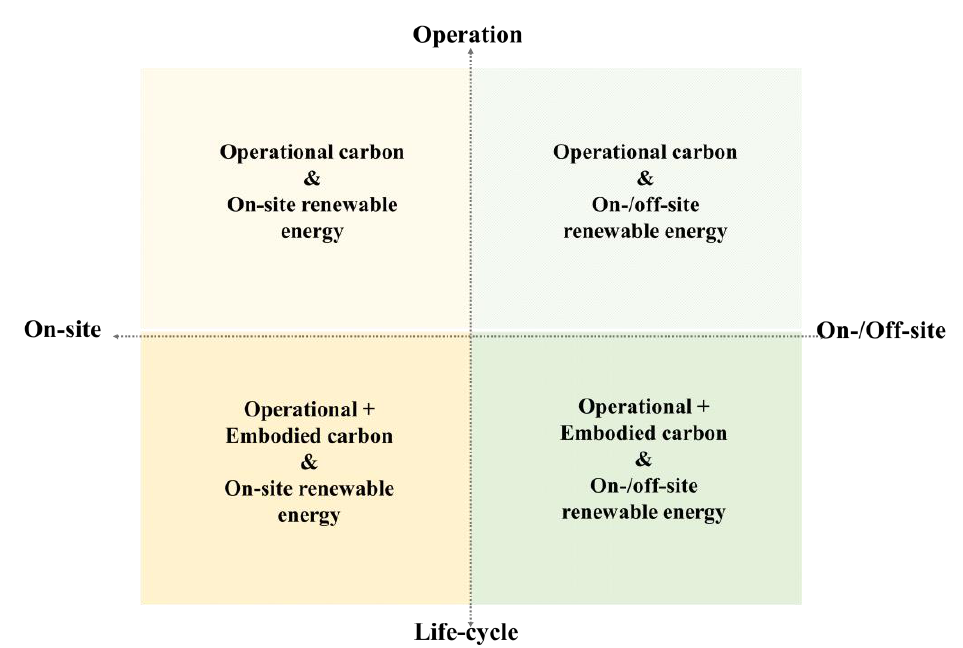
Figure 2. Different expressions of the definition of ZCBs.